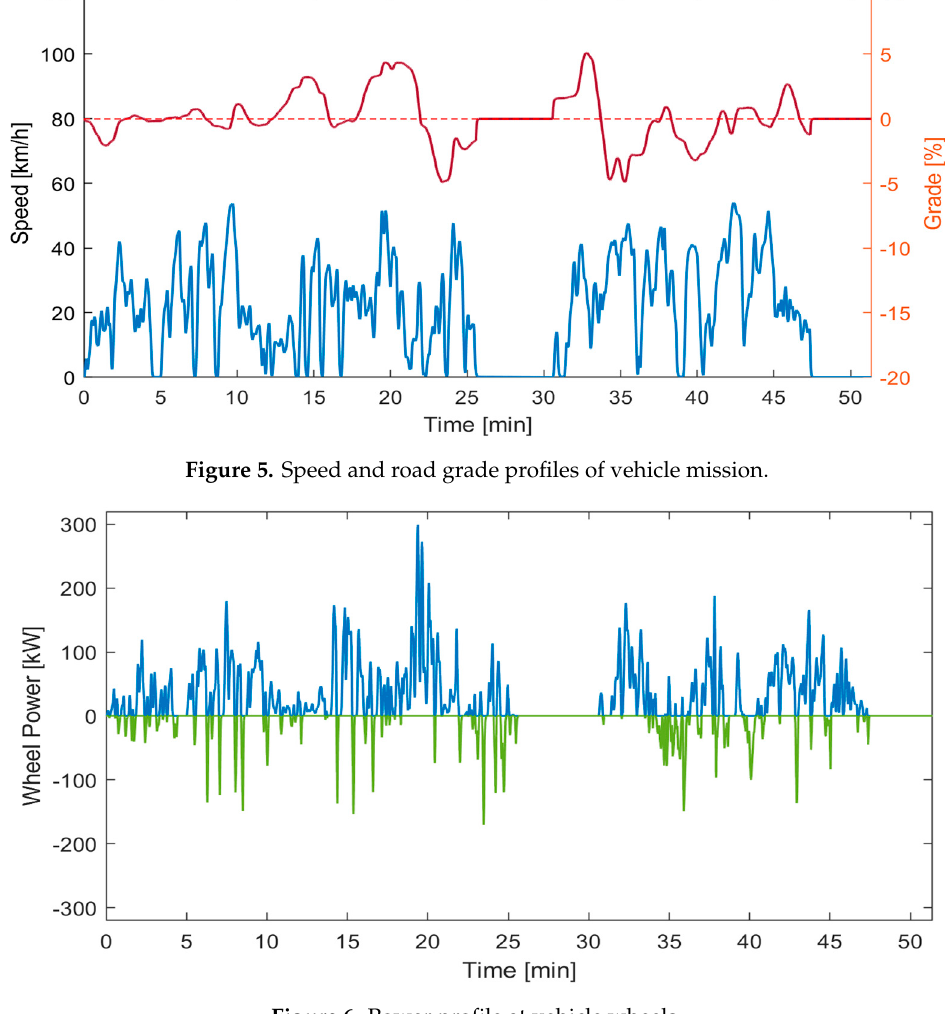
Figure 6. Power profile at vehicle wheels.